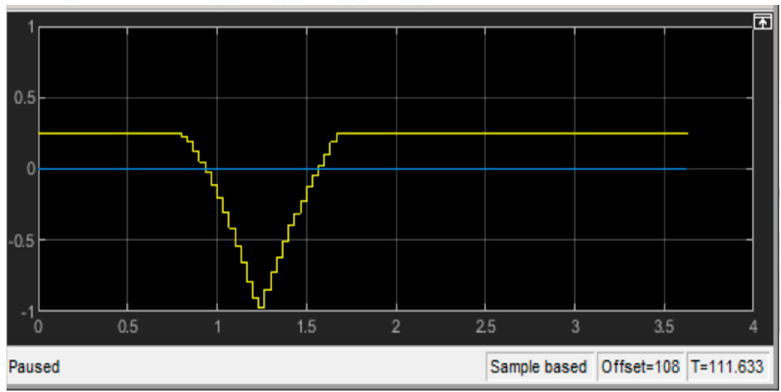
Figure 7. Exact location of the curvature.